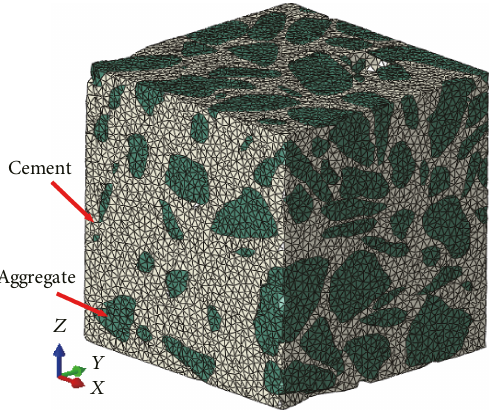
Figure 11: The XCT image-based FE